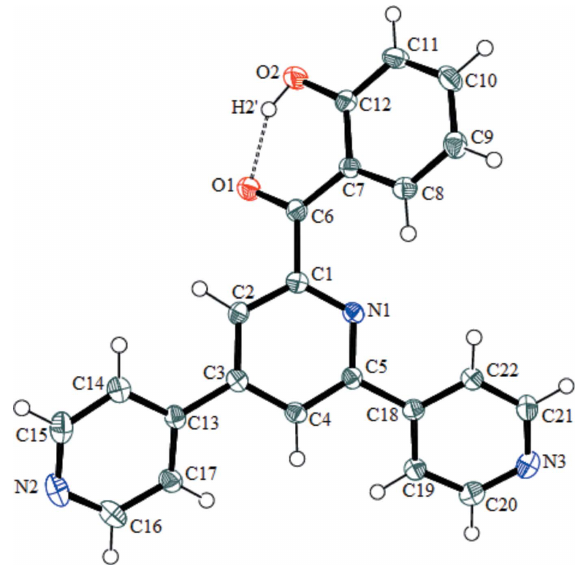
Figure 1 The molecular structure of the title compound with the atom-numbering scheme. Displacement ellipsoids are drawn at the 50% probability level. H atoms are presented as small spheres of arbitrary 39.72 (5) (cid:2) . The three six-membered rings of the terpyridine ligand are not coplanar. The dihedral angles between the mean planes of the central ring and the external pyridine ligands are 22.77 (9) and 26.77 (7) (cid:2) (for C13–C17/N2 and C18– C22/N3, respectively). A strong intramolecular O—H (cid:3) (cid:3) (cid:3) O hydrogen bond (O2—H2 0 (cid:3) (cid:3) (cid:3) O1) exists between the O1 and O2 atoms of the phenol ring (Table 1).